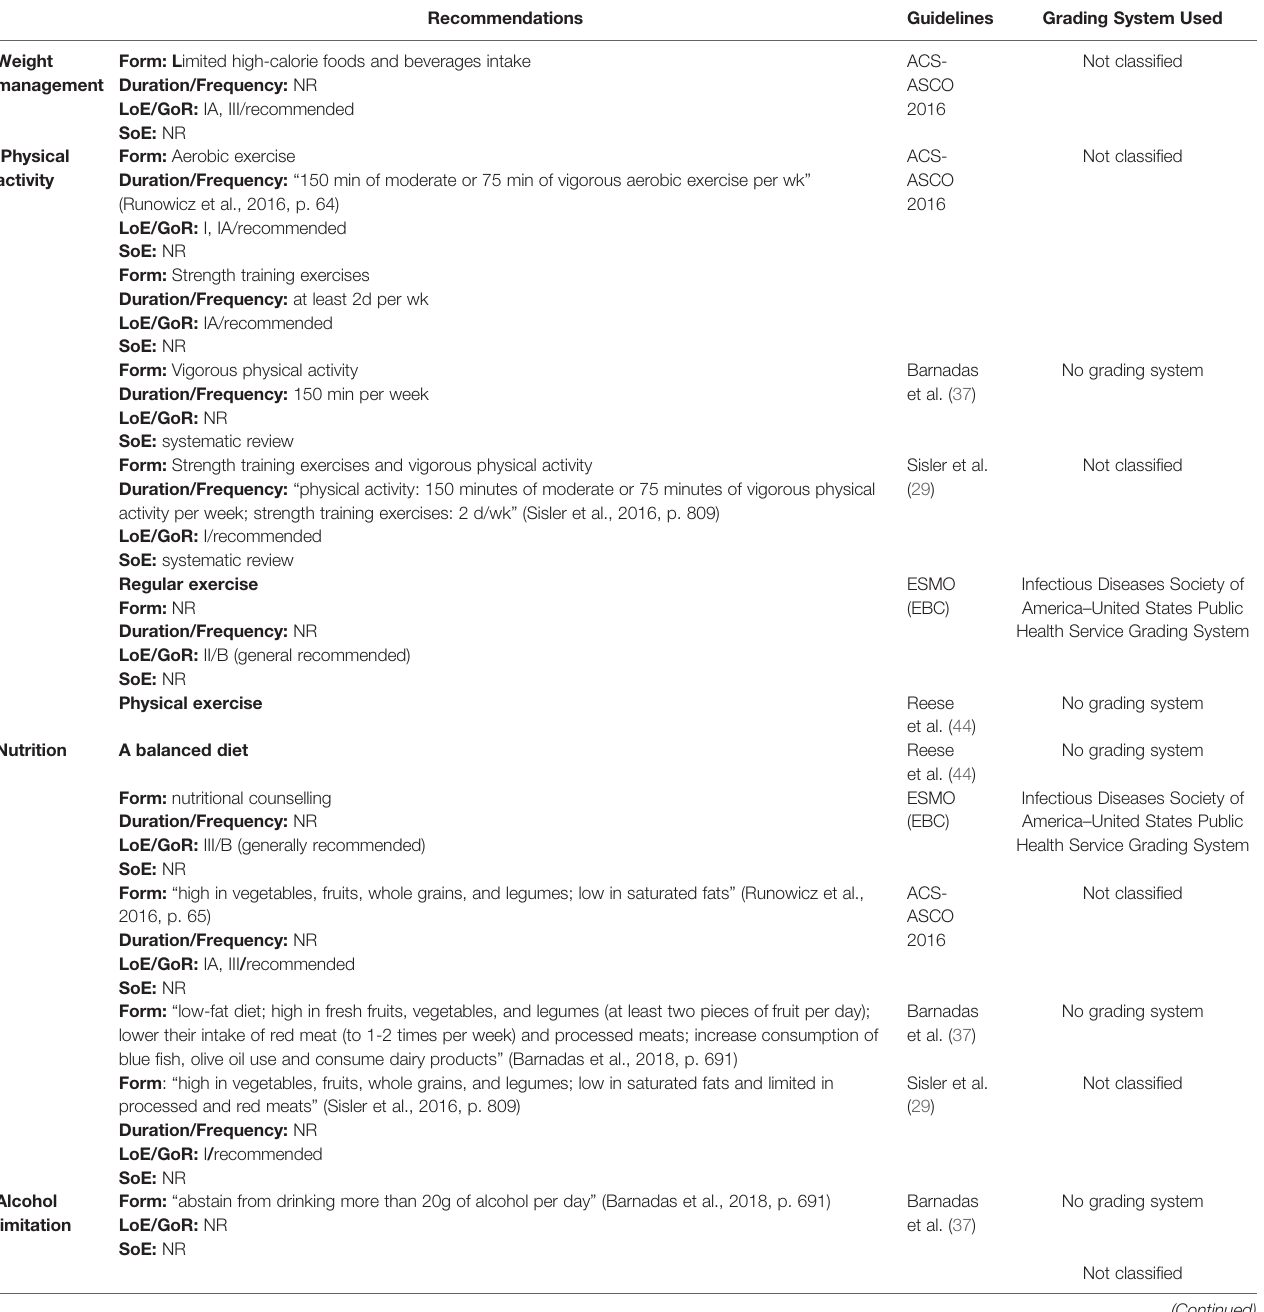
TABLE 5 | Health promotion for breast cancer survivors per the included clinical practice